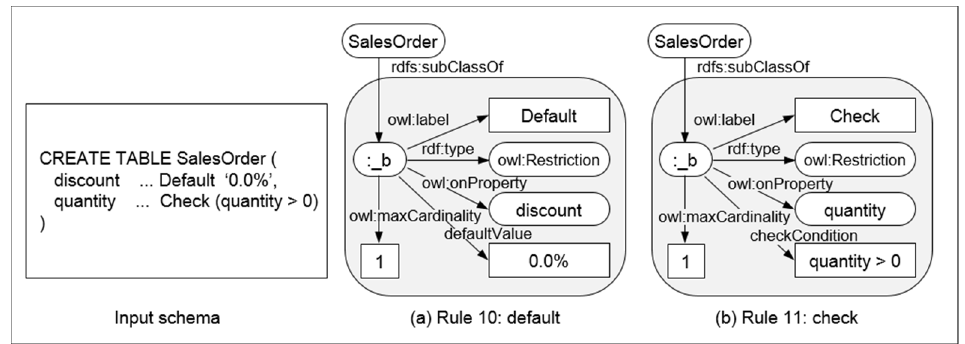
Figure 17. Examples of mapping integrity constraints (Rule